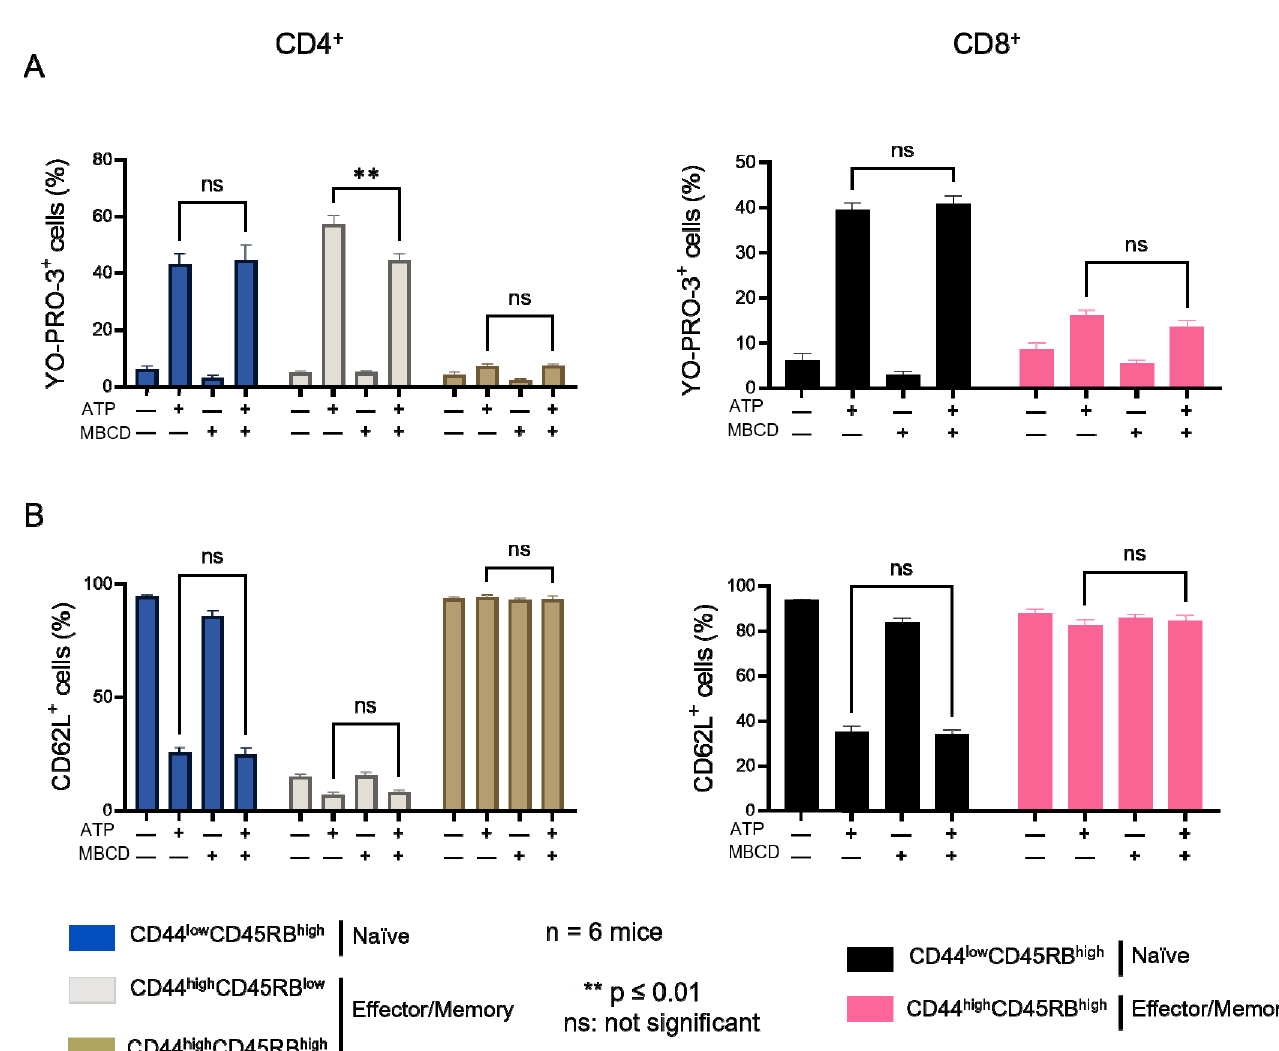
Figure A2. Amplitude of P2X7-induced cellular responses in T cells following plasma membrane cholesterol depletion by MBCD. Amplitude of P2X7-mediated pore formation ( A ) and CD62L shedding ( B ) were evaluated among CD44 low CD45RB high naïve and CD44 high CD45RB low or CD44 high CD45RB high effector/memory CD4 + and CD8 + T-cell subsets in the presence of 500 µM eATP for 30 min at 37 °C following ex vivo plasma membrane cholesterol depletion using 5 mM MBCD for 20 min at 37 °C. Data are expressed as the mean of percentages (±SEM, n ≥ 6 mice). Asterisks denote statistically significant differences ** p ≤ 0.01, ns: not significant.